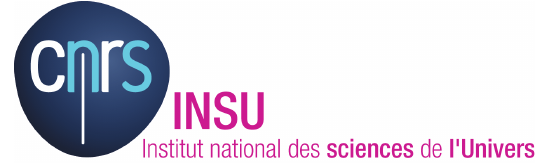
Fig. 11: Occurrence of the mean-square error ( in the PBL between aerosol extinction coefficient retrieved from (a) CALIOP level-2 and MODIS-Aqua/CALIOP synergy and (b) CALIOP level-2 and MODIS-Terra/CALIOP synergy for daytime (light gray), night-time (black) and all data (dark gray).